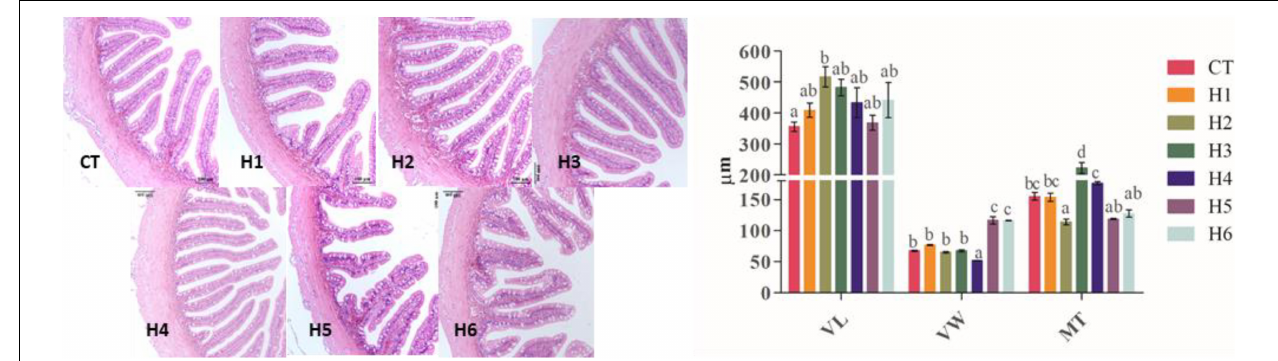
FIGURE 7 | Effect of HFP on the intestinal morphology of juvenile pearl gentian hybrid grouper (H&E, 20 × ). VL, villus length; VW, villus width; MT, muscle thickness.